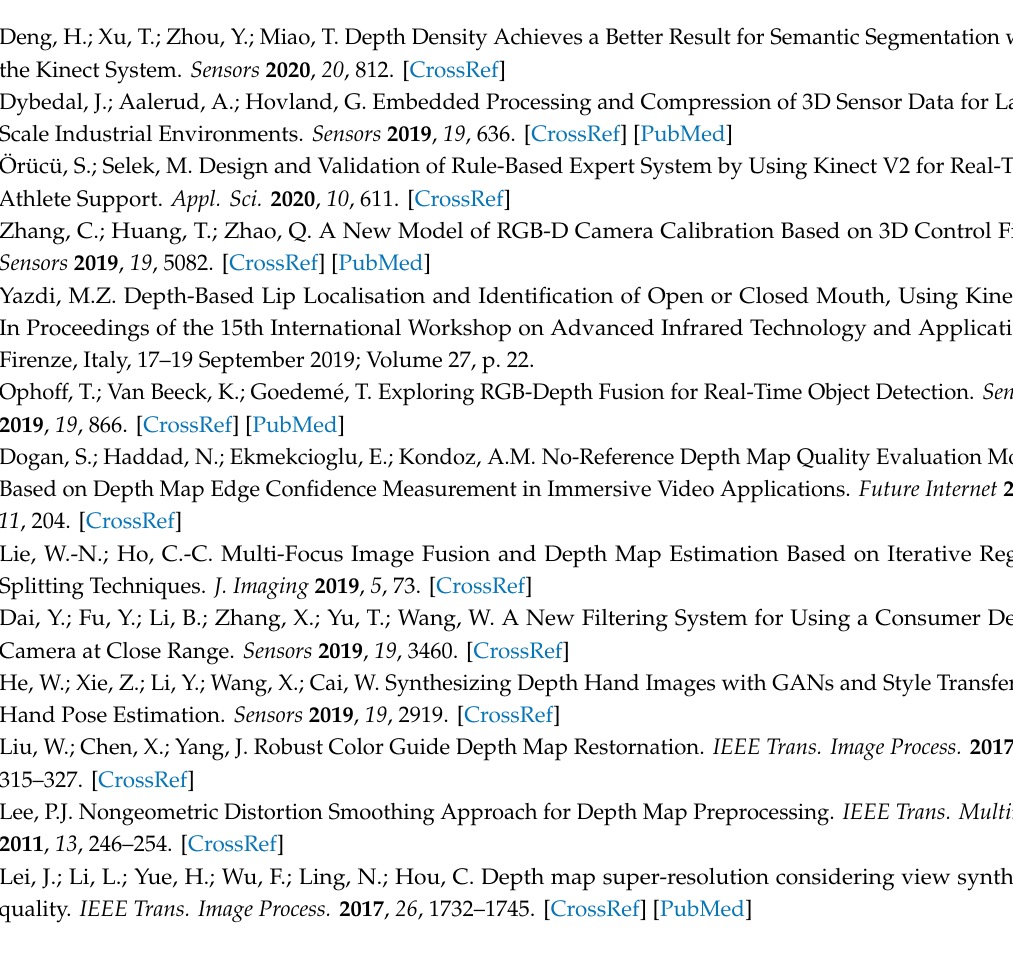
Figure 9. Visual Figure 9. Visual quality.